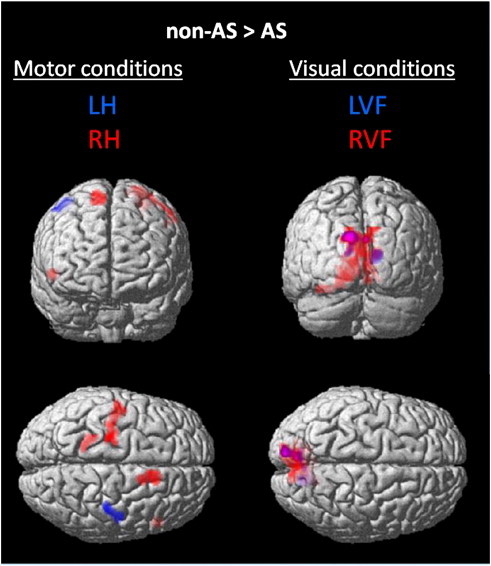
Areas of stronger activation in non-autistic (non-AS) than in autistic (AS) individuals are displayed. Group difference in task-related activity for the motor (left hand (LH) in blue, right hand (RH) in red (LVF and RVF pooled)) and visual (left visual field (LVF) in blue, right visual field (RVF) in red (LH and RH pooled)) contrasts. Threshold: p < .05, FWE, cluster correction k = 50.